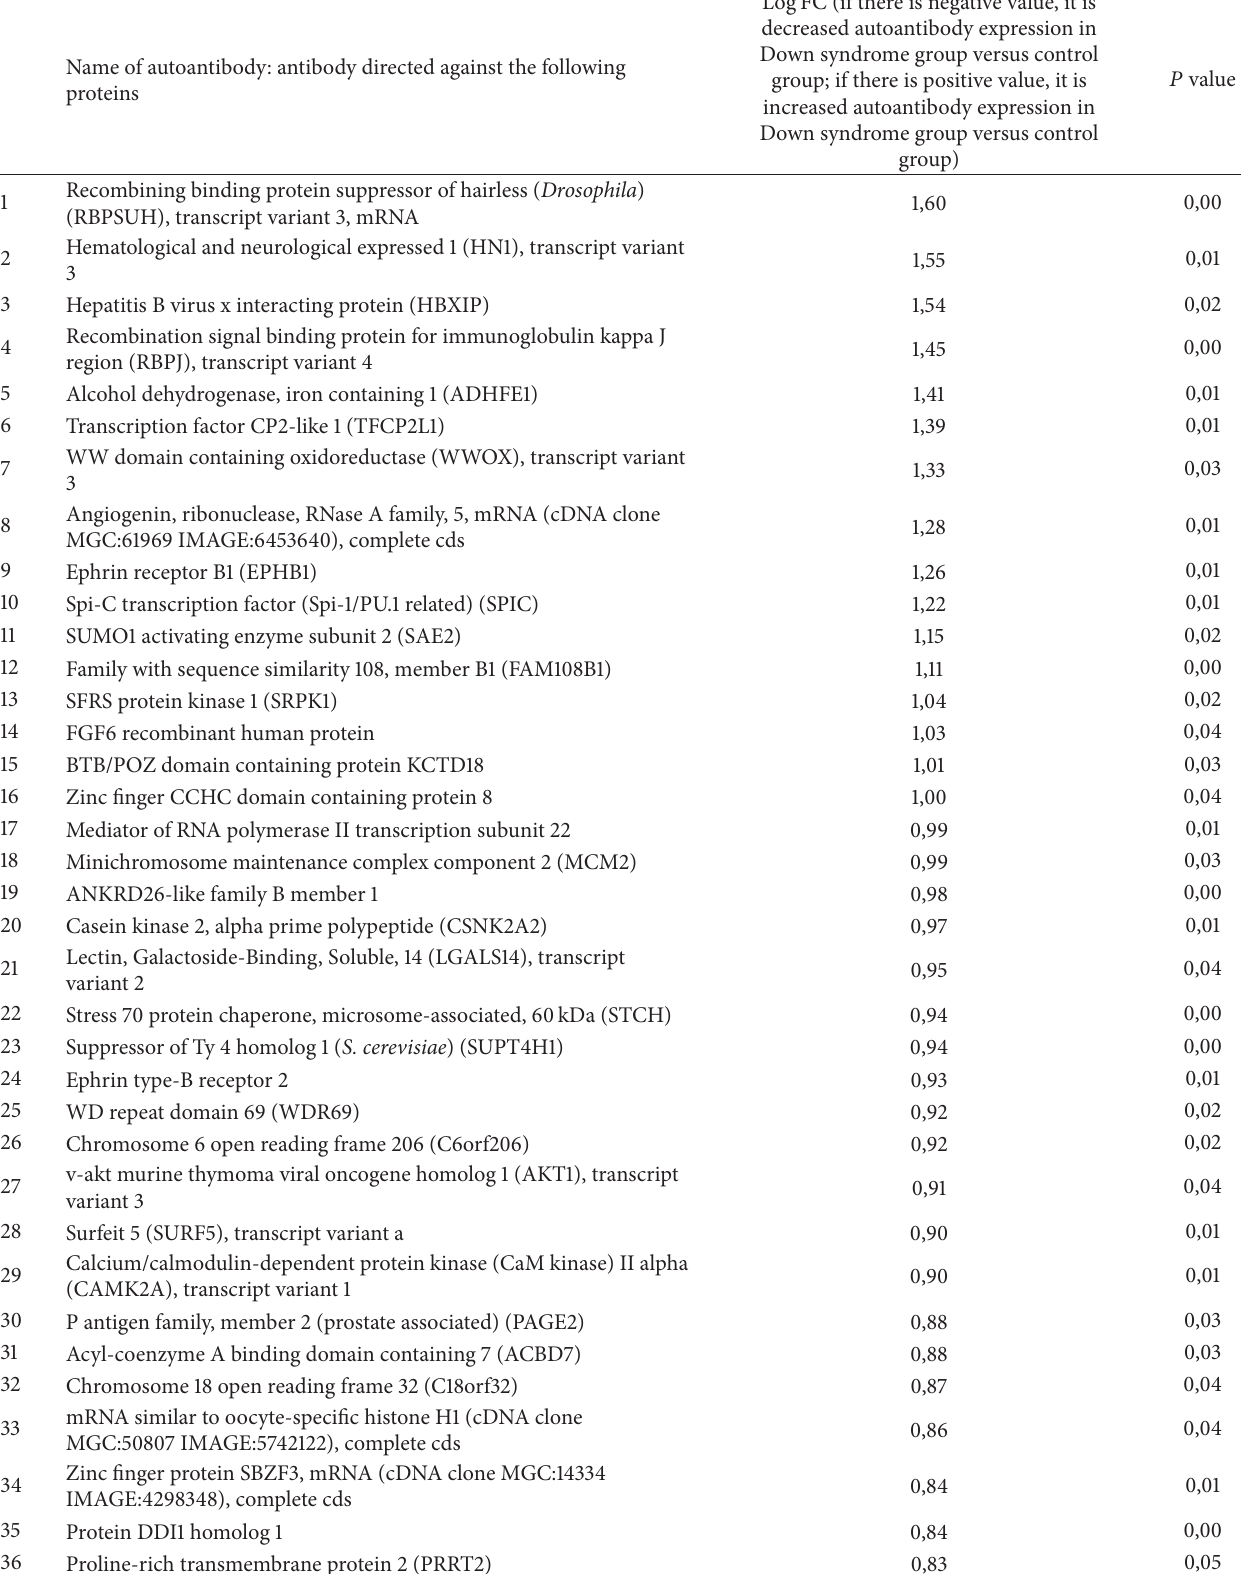
Table 2: The 213 statistically significant autoantibodies, whose expression decreased or increased in the group with fetal Down syndrome in comparison to the control